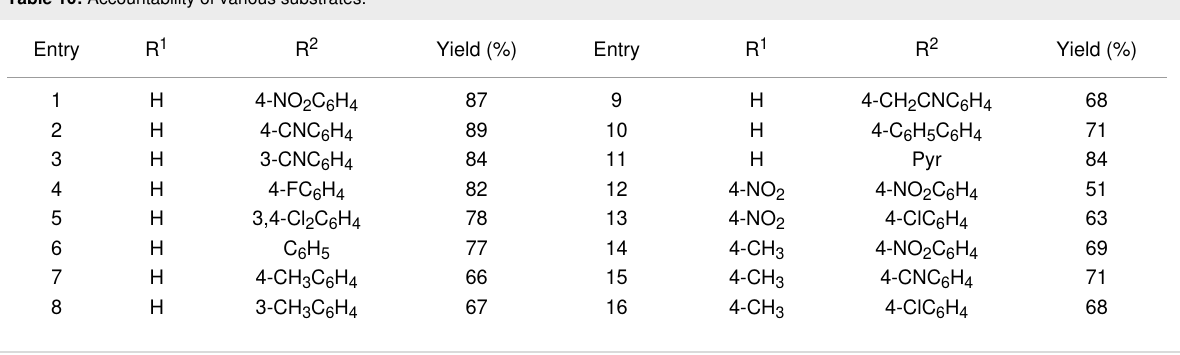
Table 10: Accountability of various